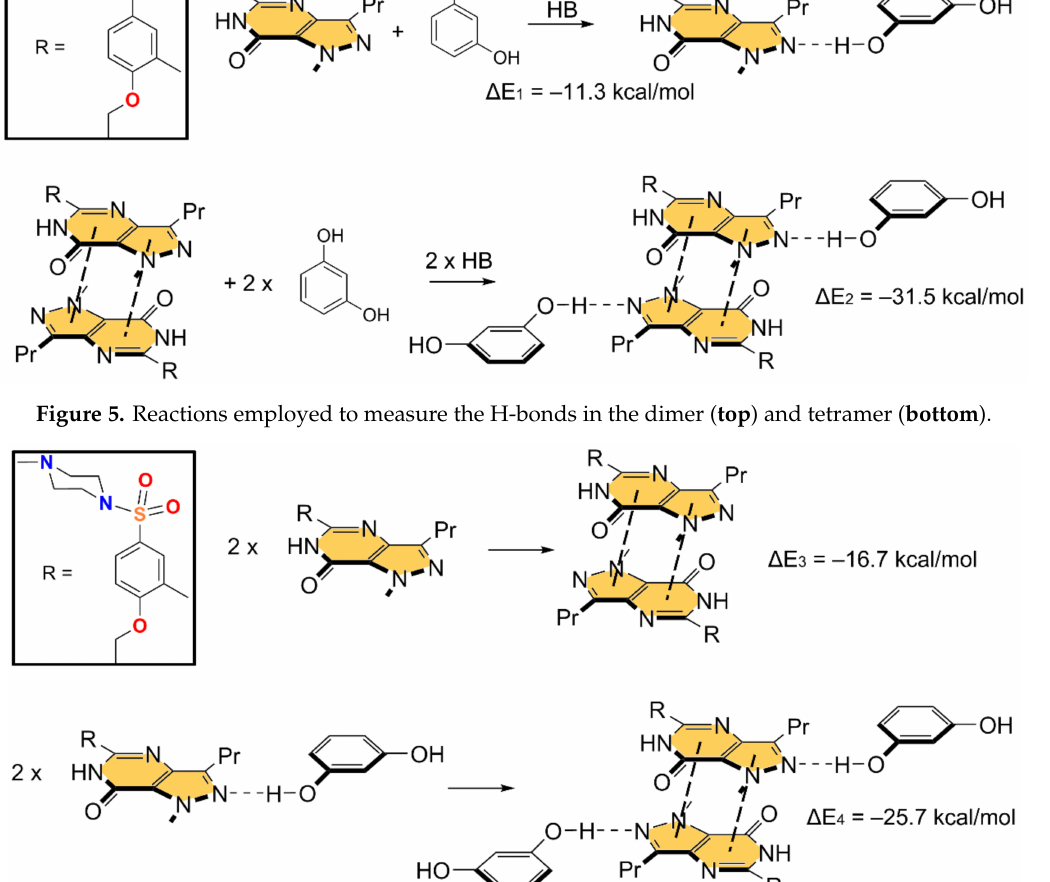
Figure 6. Reactions employed to measure the π -stacking in the dimer ( top ) and tetramer ( bottom